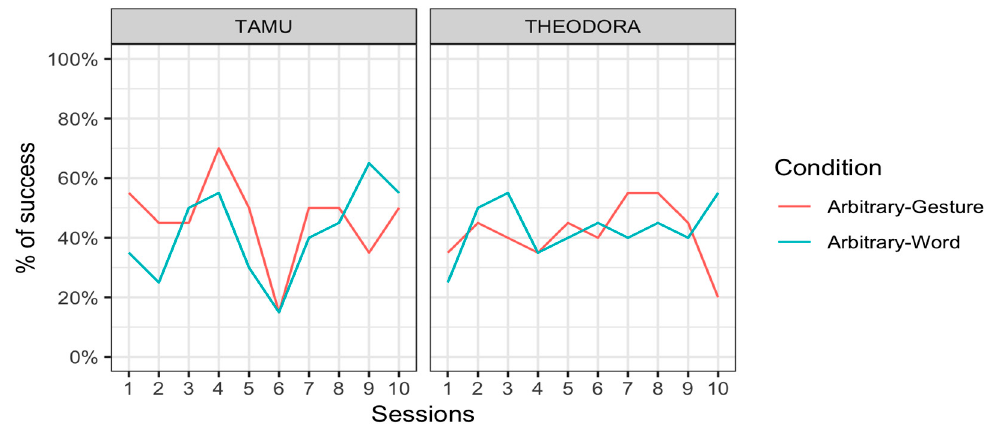
Figure 5. Percentage of successful responses (mean) of the orangutans Tamü (left) and Theodora (right) in the Arbitrary–Gesture condition (pink line) and the Arbitrary–Word condition (blue line) for the 10 sessions.